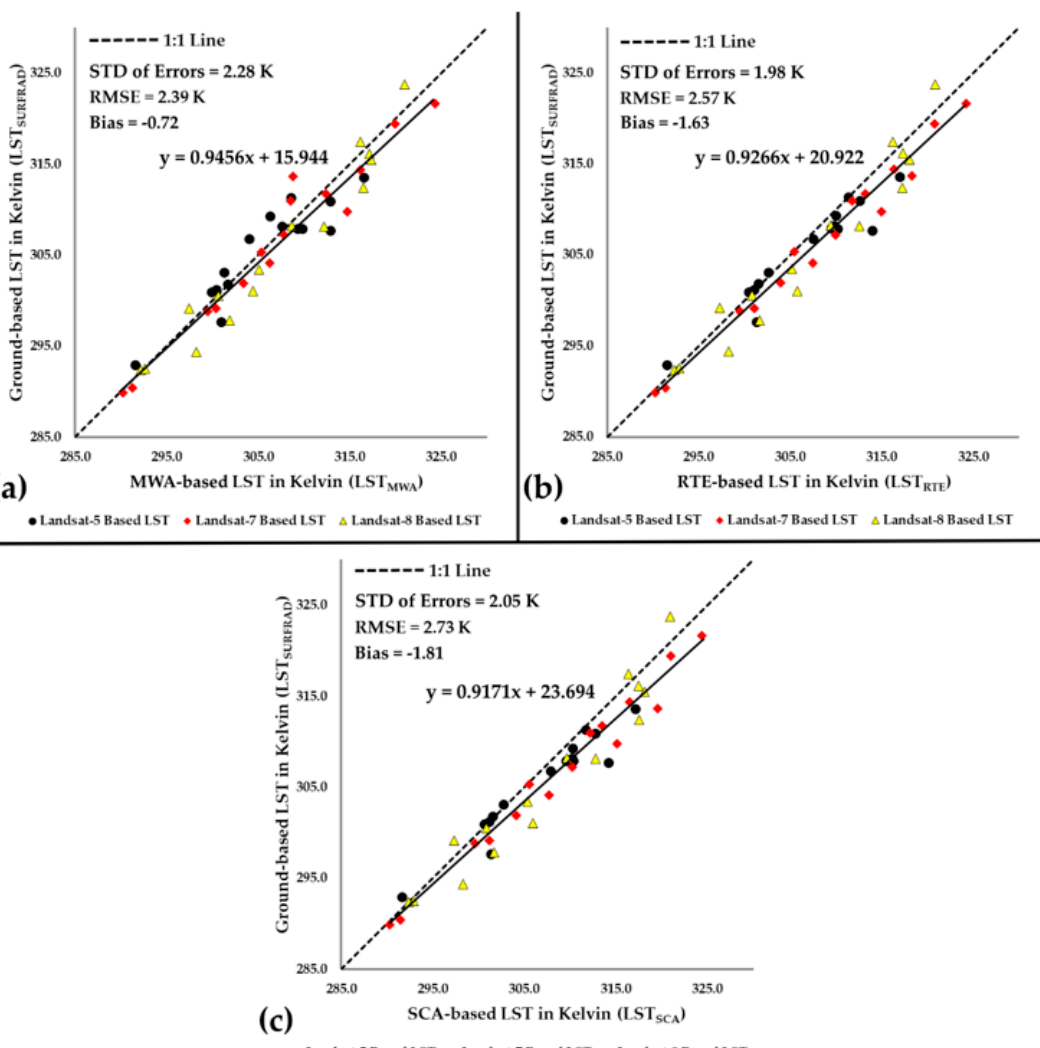
Figure 1. Accuracy assessment and the comparison of method-based LST results with ground-based LST: a) Comparison between Mono Window Algorithm (MWA)-based LST and LST SURFRAD , b) Comparison between Radiative Transfer Equation (RTE)-based LST and LST SURFRAD , c) Comparison between Single Channel Algorithm (SCA)-based LST and LST SURFRAD .